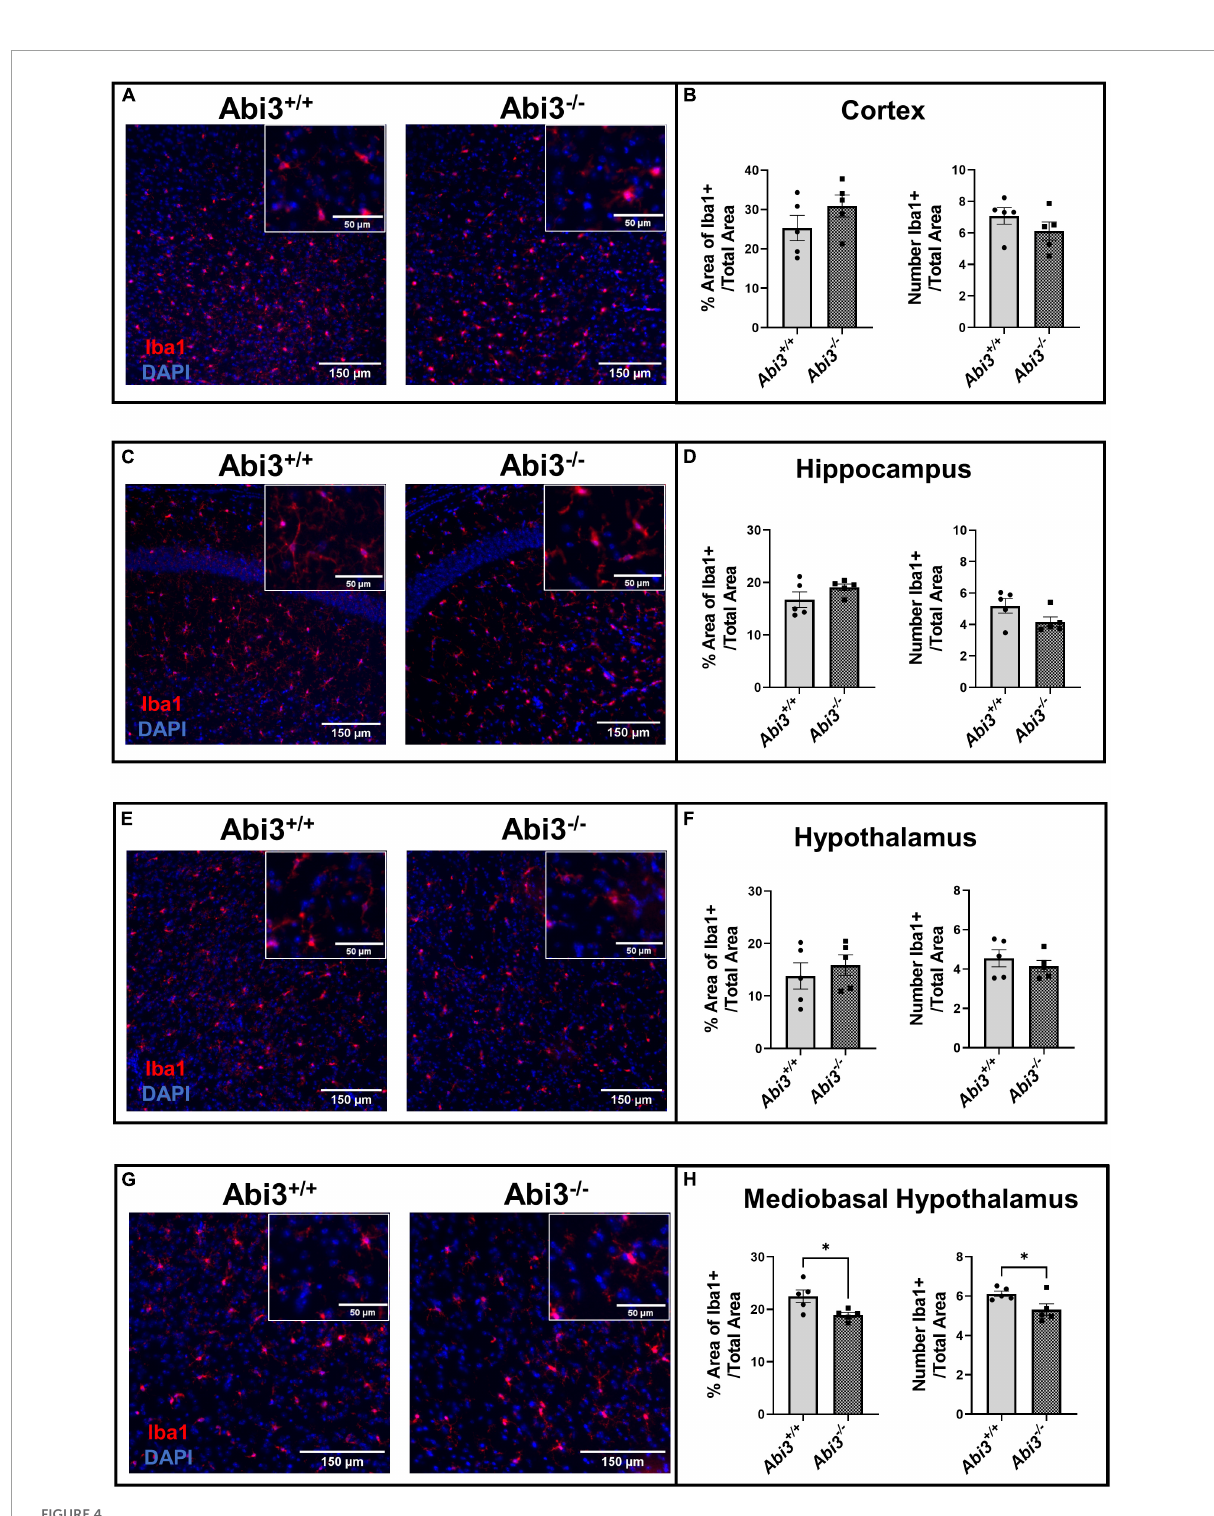
FIGURE4 Deletion of Abi3 gene locus reduces microglia number and area within the mediobasal hypothalamus, but not other brain regions. Coronal brain sections from 15-month-old male Abi3 + / + ( n = 5) and Abi3 - / - mice ( n = 5) were stained with Iba1+ (microglia marker) and DAPI (nuclear counterstain). (A,C,E,G) Representative images, for each brain region, show Iba1 + signal in red and DAPI in blue. (B,D,F,H) The number of microglia and area occupied by microglia were quantified across these brain regions. The area and number of Iba1 + signal was measured in the (A,B) cortex, (C,D) hippocampus, (E,F) whole hypothalamus, and (G,H) mediobasal hypothalamus. Data represent mean ± SEM. Unpaired t -test; ∗ p <